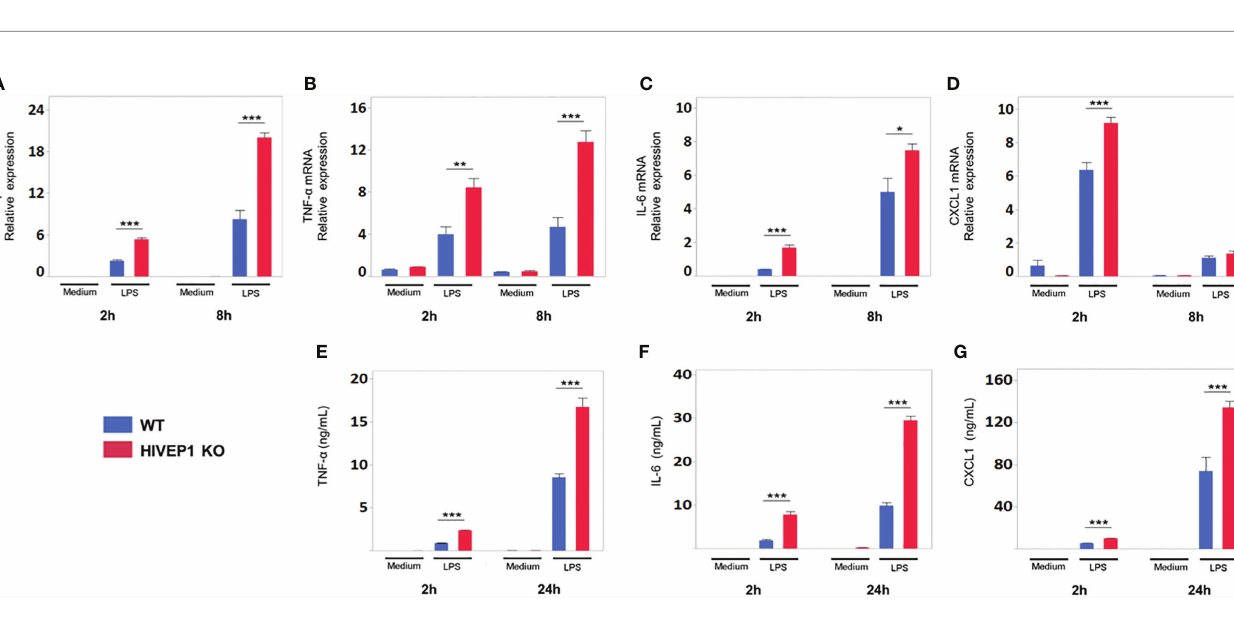
infection with Streptococcus (S.) pneumoniae . This pathogen is a represent a suitable model system to study the pathophysiology of infections caused by S. pneumoniae (20). The HIVEP1 speci fi c